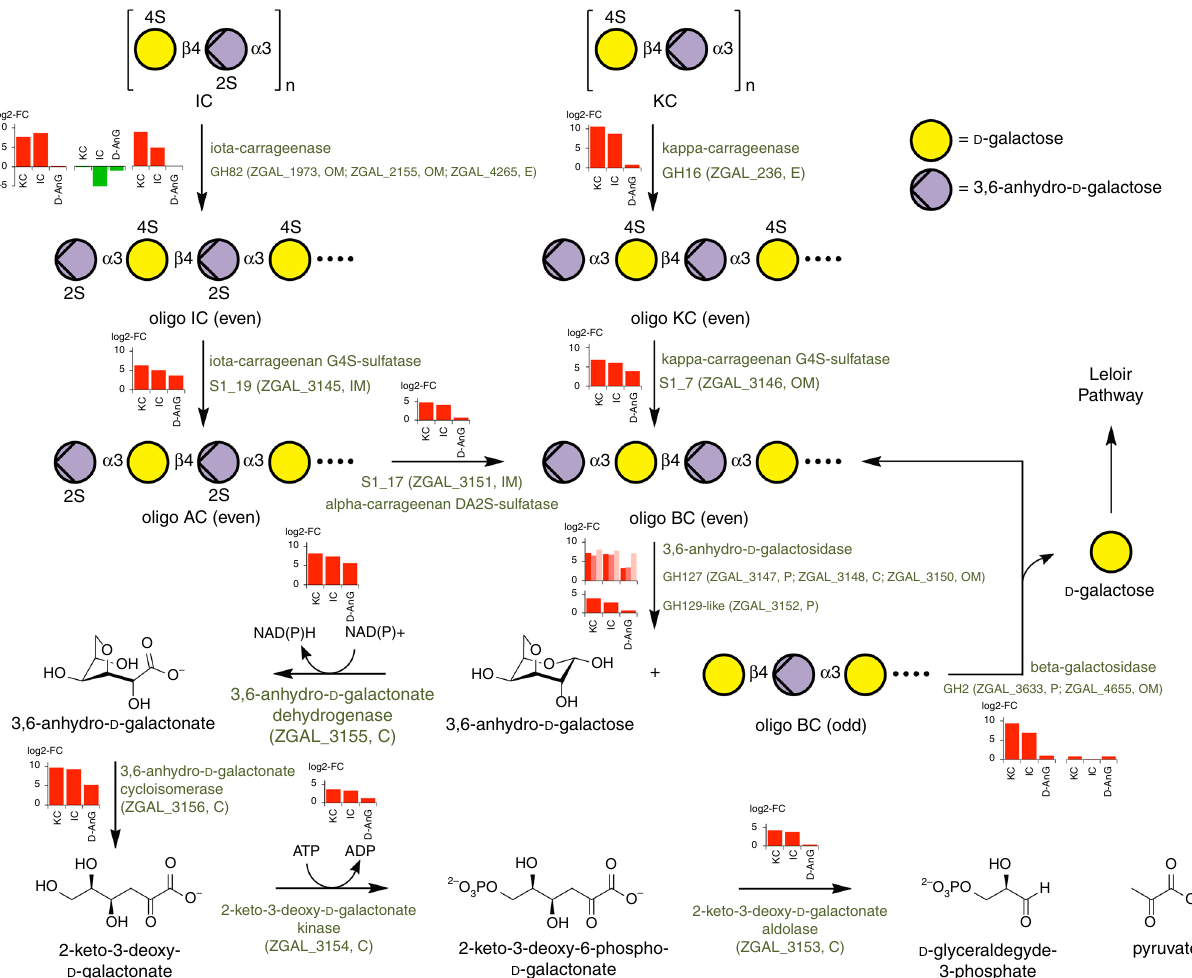
Fig. 3 Kappa-carragenan and iota-carrageenan catabolic pathways in Z. galactanivorans . Enzymes performing each reaction step are mentioned, together with their encoding genes. For each step, bar plots depict the relative expression of the corresponding gene(s) in kappa-carrageenan (KC), iota- carrageenan (IC), or 3,6-anhydro- D -galactose (D-AnG) compared to D -galactose, as measured by RNA-seq (values are mean of log2-fold change, n = 3). Predicted enzyme localization is shown next to the gene number: OM, outer membrane; IM, inner membrane; E, extracellular; C, cytoplasmic; P, periplasm. AC stands for alpha-carrageenan and BC for beta-carrageenan. In this schematic, alpha- and beta-carrabiose motifs are considered as intermediary compounds. Nonetheless, alpha- and beta-carrageenans can be naturally found in some red algal species and the catabolic pathway described here is also valid for these natural